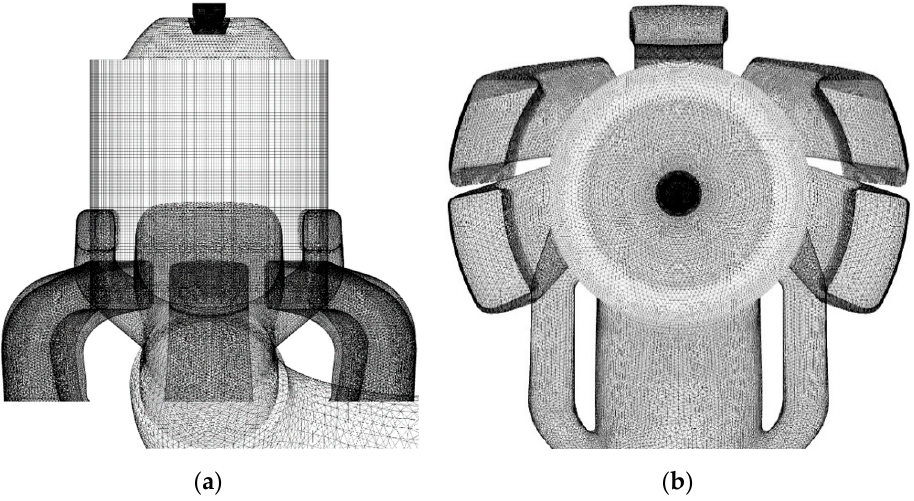
Figure 4. ( a ) Side view of the mesh of the fluid domain, including PN6 prechamber; ( b ) top view. Table 5. Details of the mesh used for the PN6 and PN8 prechambers.